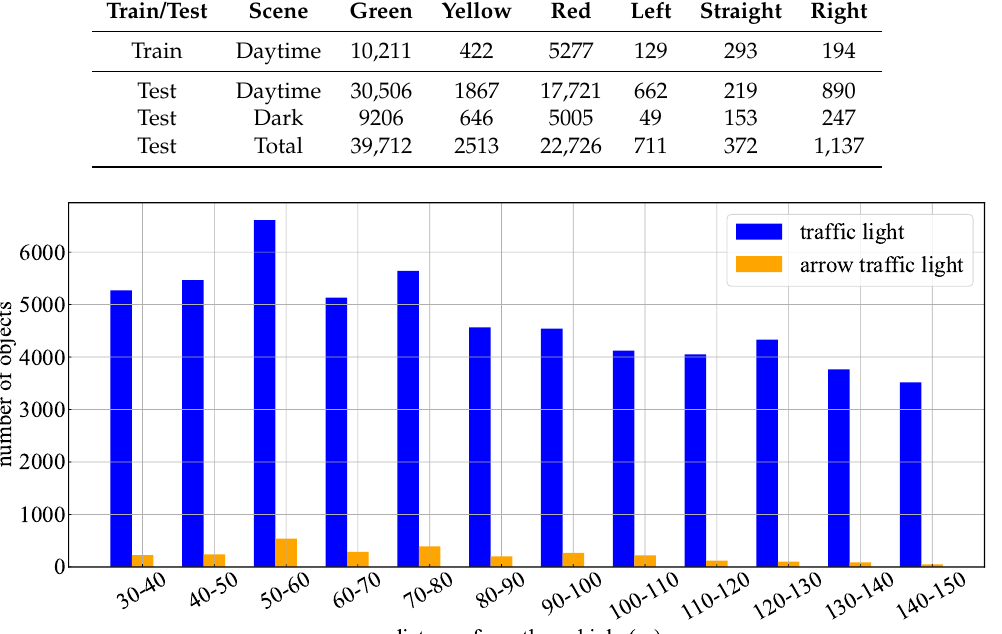
Table 2. Experimental conditions: number of data.